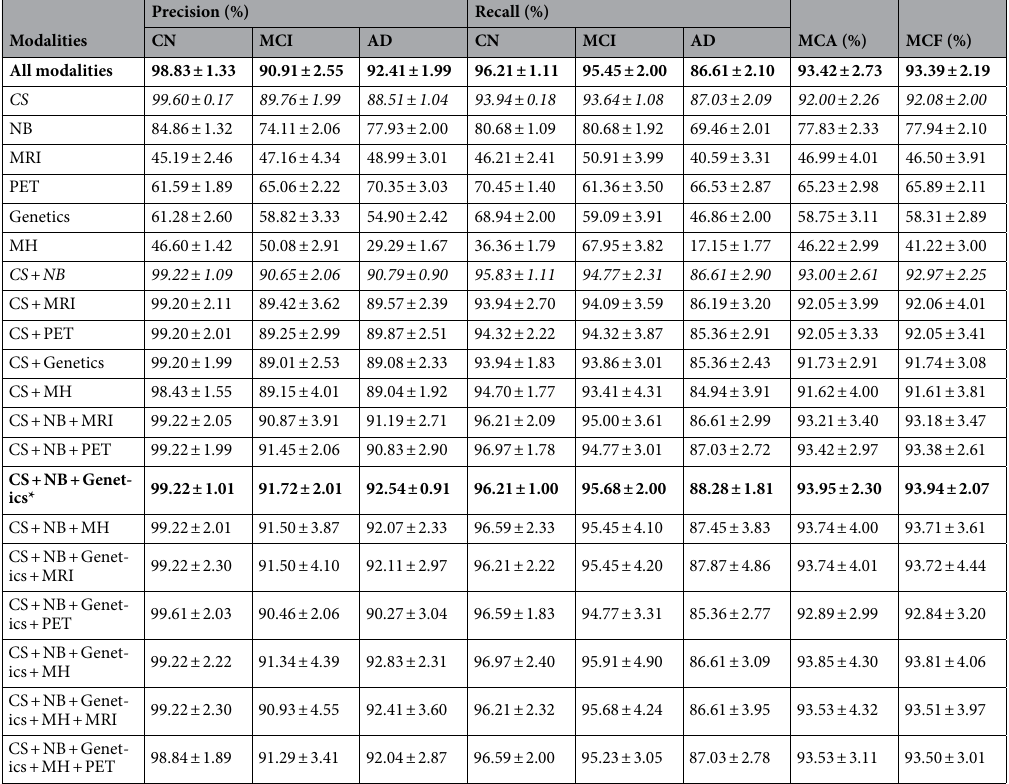
Table 2. Random Forest performance validation for detecting AD patients based on tenfold cross-validation . MCA: multiclass classification accuracy, MCF: multiclass F1 score; Asterisk ( *): is the subset of features with the best predictive performance; italic text is the best of single and pairs of